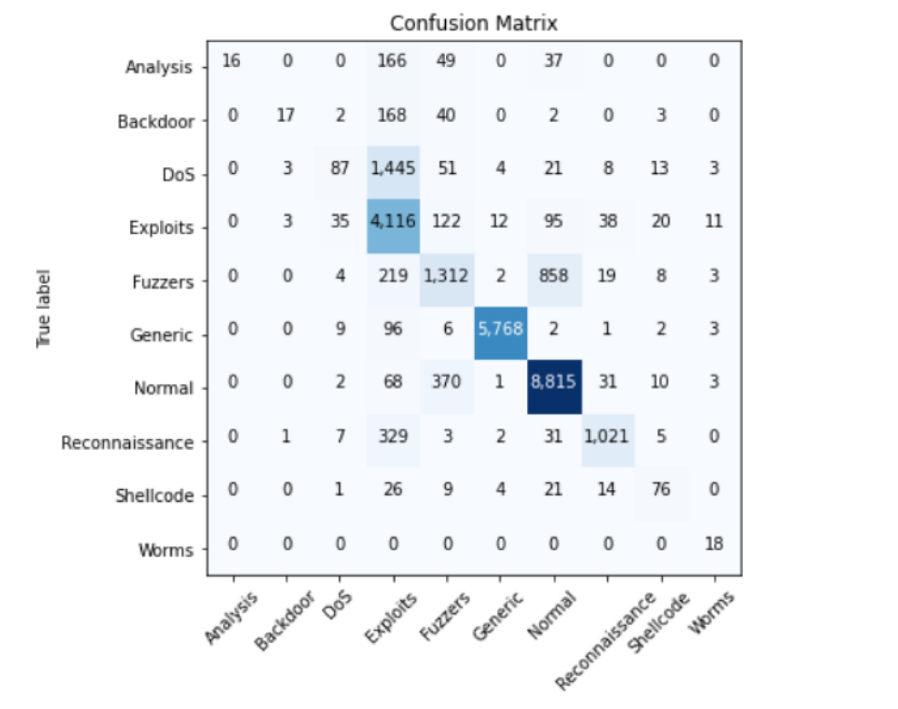
Figure 5. Confusion